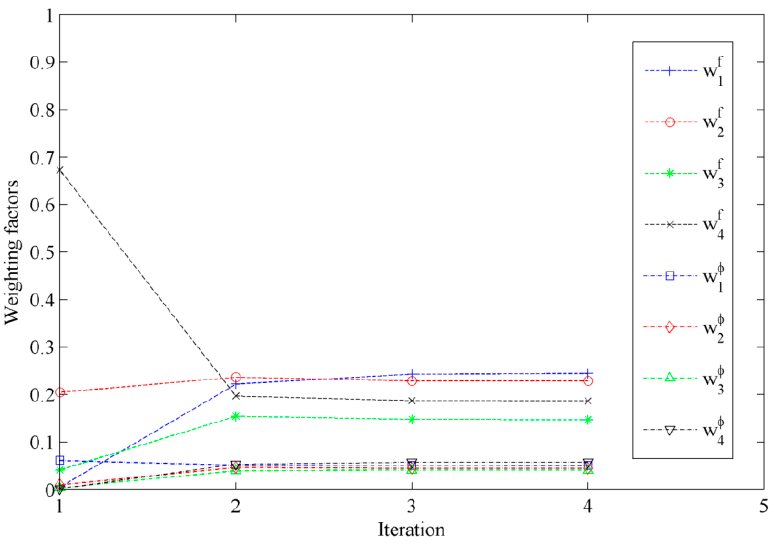
Figure 3. The evolution of the optimal weighting factors with iteration steps (case 1).